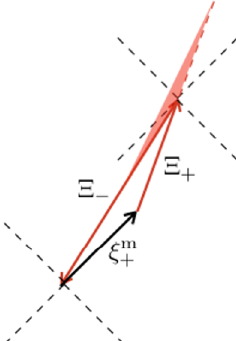
Figure 4 . Formation of the closed causal curve is shown for the solution in the right panel of (cid:12)gure 2. Once the future cone for the galileon perturbations opens up enough, so that the characteristic (cid:4) (cid:0) crosses the characteristic (cid:24) m of the normal matter, closed causal curves appear. If one follows the + characteristic (cid:4) (cid:0) back in time, then takes a characteristic of the ordinary matter (cid:24) m continues along the characteristic (cid:4) + , a closed causal curve will be